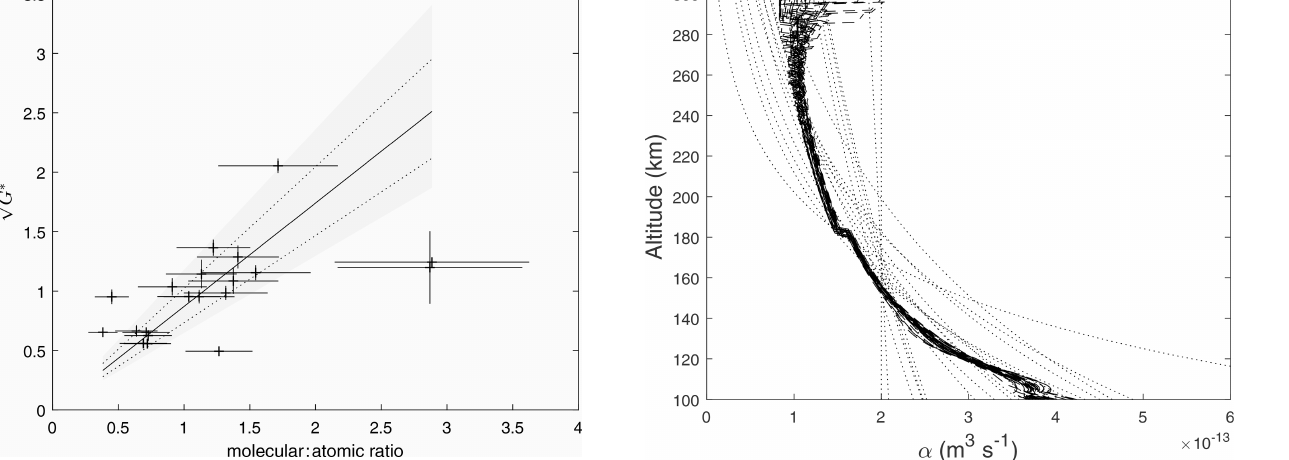
Figure 7. A comparison between the height profiles of the molec- ular loss rate, α , estimated using the International Reference Iono- sphere (dashed black lines) and from the simple assumption that this loss rate varies as the inverse of the scale height (dotted lines) for the overpasses used in this